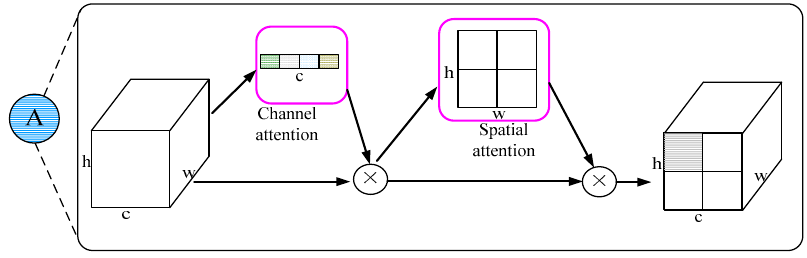
Figure 3. The proposed attention module includes the channel attention and spatial attention.